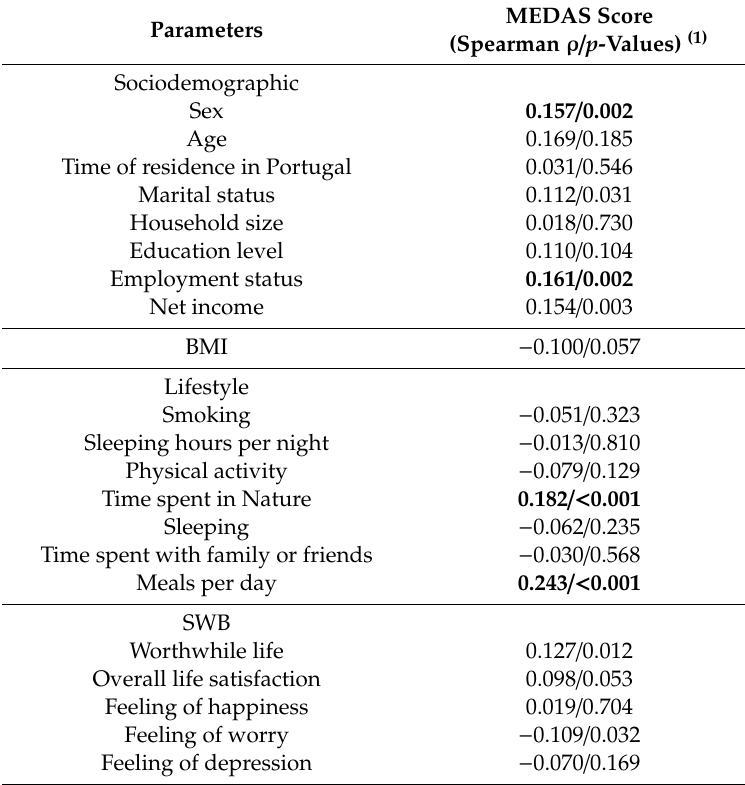
Table 6. Correlations of sociodemographic characteristics, BMI, SWB, and lifestyle habits with the adherence to the Mediterranean diet (MEDAS